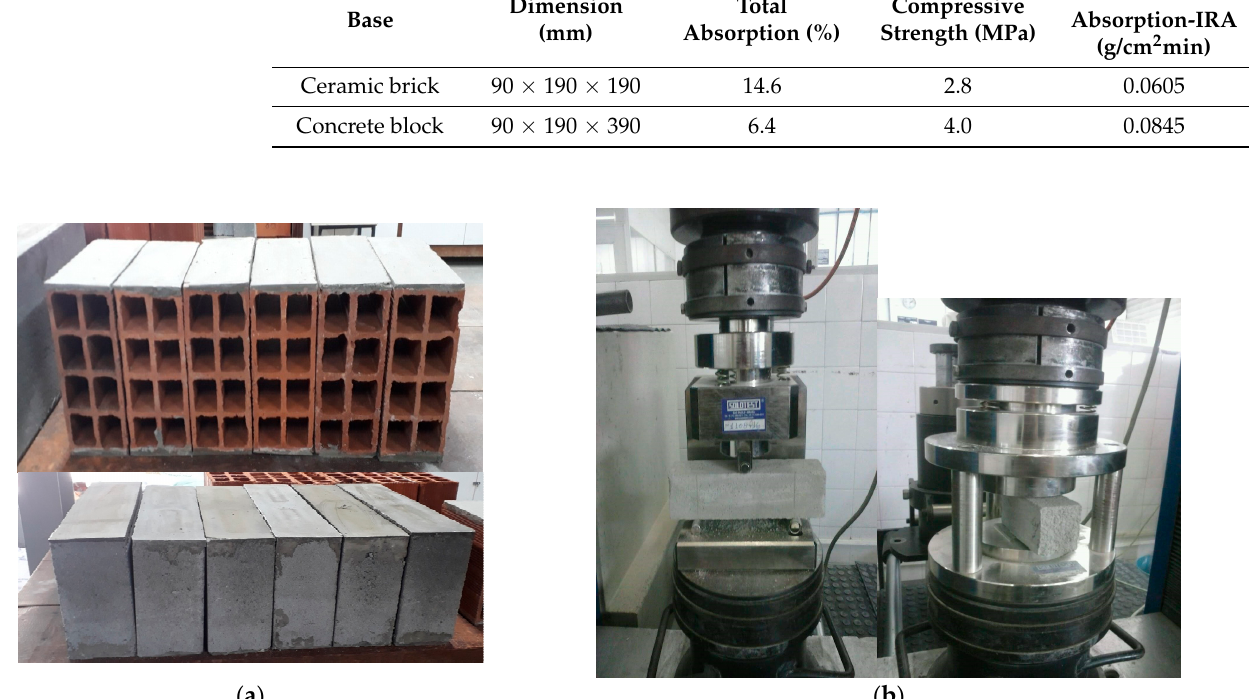
Figure 5. ( a ) Ceramic and concrete blocks used and ( b ) tensile test in flexion and compression test on mortar prims.